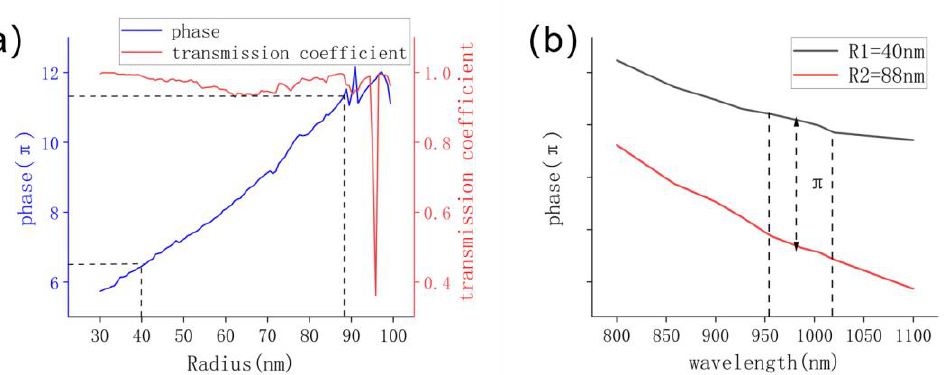
Figure 6. ( a ) Curve of phase change and transmittance of the helical waveguide as the radius R of the helix varies from 100 nm to 200 nm. ( b ) The transmission phase difference of the helical waveguide with two radii of R 1 = 40 nm and R 2 = 88 nm.